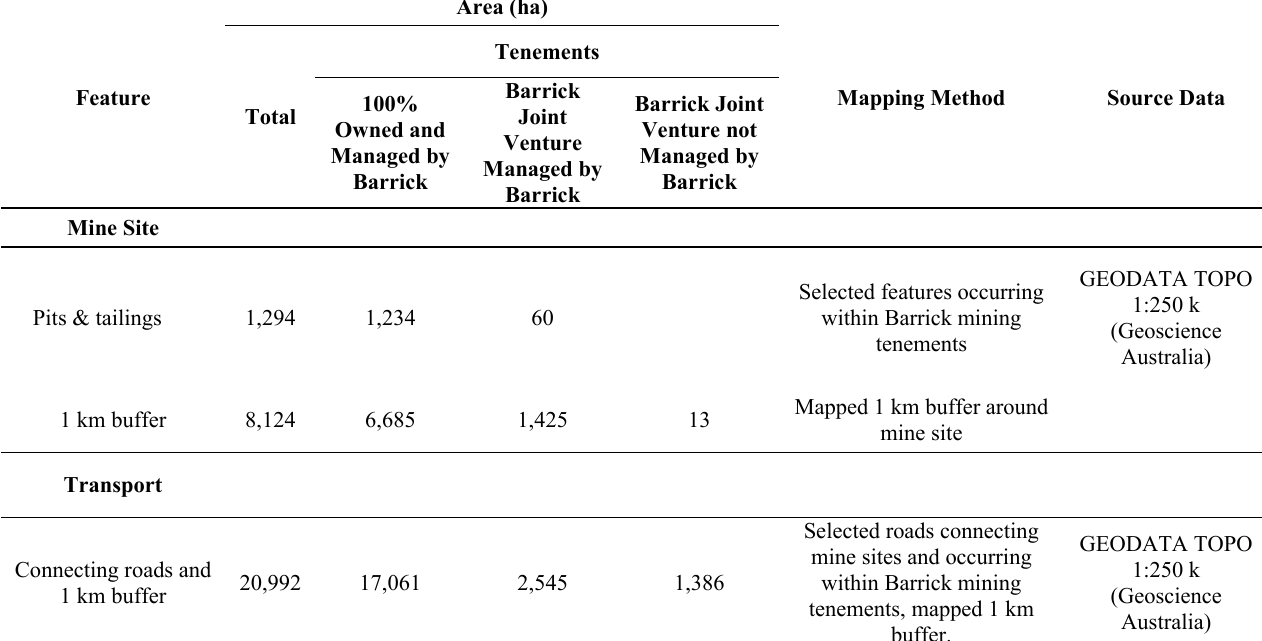
Table 2. Mine footprint components at Kanowna Belle mine